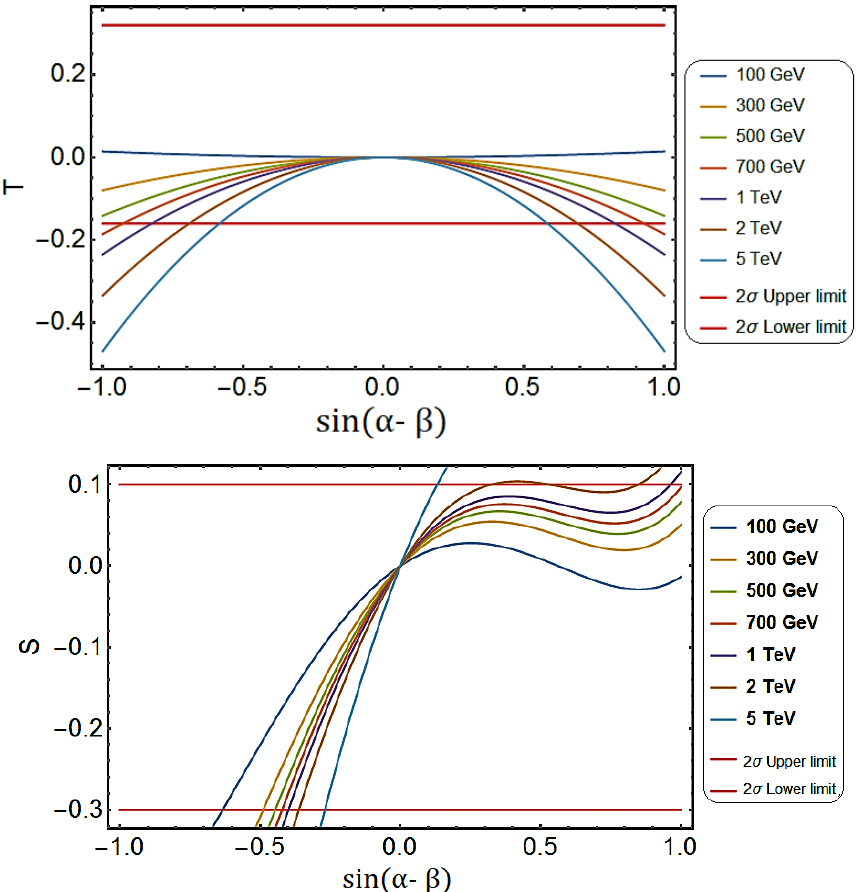
Figure 15 . Top: T parameter as a function of sin( (cid:11) (cid:0) (cid:12) ) for di(cid:11)erent masses of the (degenerate) heavy Higgs bosons. Bottom: S parameter as a function of sin( (cid:11) (cid:0) (cid:12) ) for di(cid:11)erent masses of the heavy